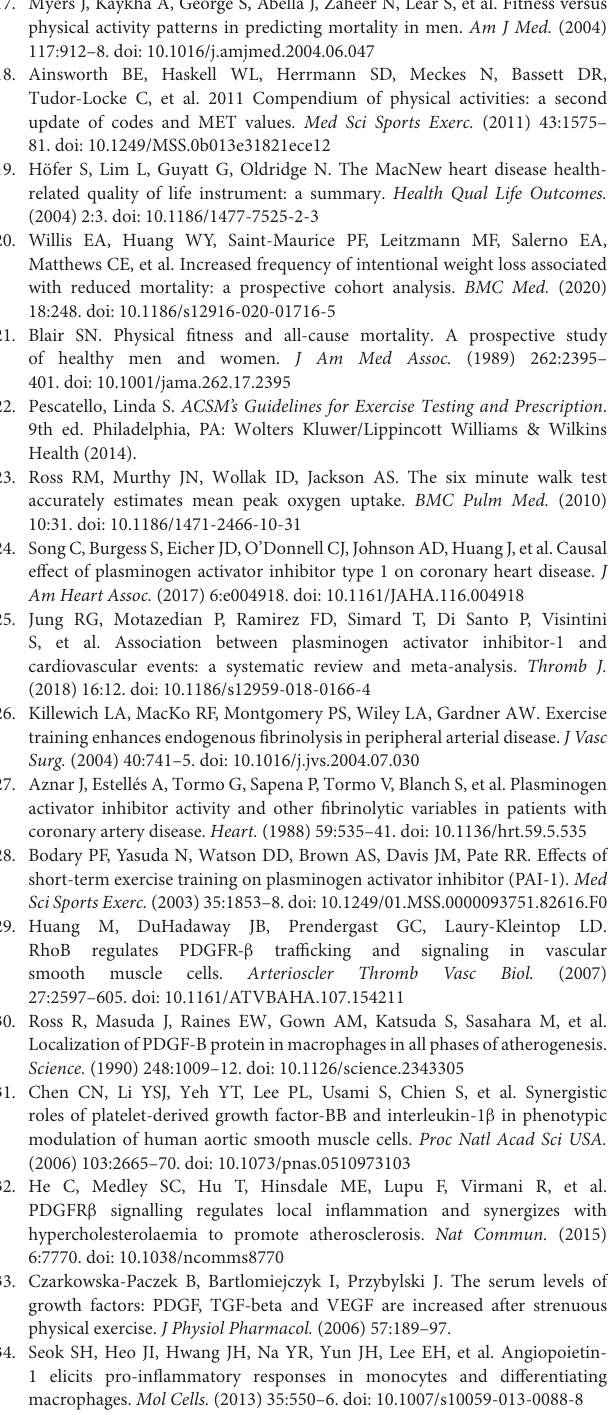
Supplementary Figure 2 | Two-way scatter plot showing the relationship between biomarkers measured by the OLINK and ELISA assays. Spearman correlation coefficient ( r 2 ) = r 2 = 0.7925, p -value < 0.0001 for plasminogen activator inhibitor-1 (PAI-1); Spearman correlation coefficient ( r 2 ) = 0.717; p -value Supplementary Table 1 | List of cardiovascular biomarkers measured by